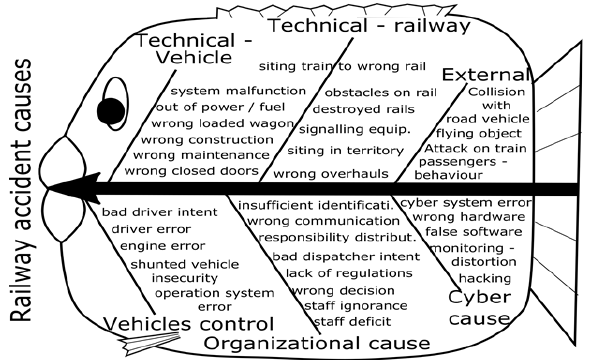
Figure 5. Causes of railway accidents in the Czech